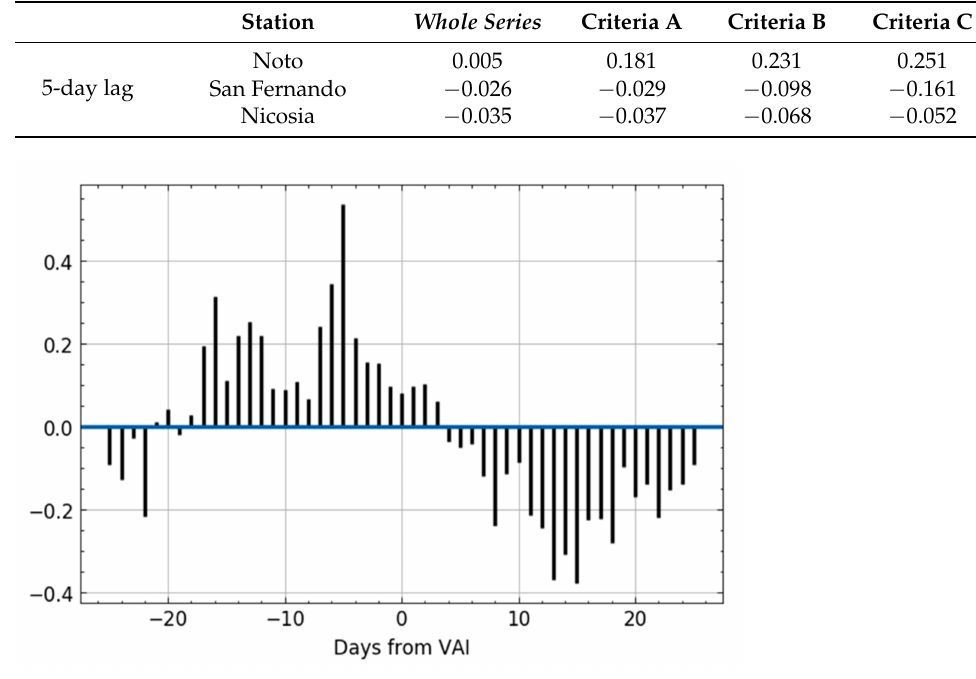
Figure 13. Comparison of minimum night TEC patterns for IGS Noto, IGS San Fernando and IGS Nicosia during non-active days (NAD). Table 3. Five-day lagged Pearson correlation coefficients between time-series of VRP and TEC for all locations, including whole datasets and defined criteria.